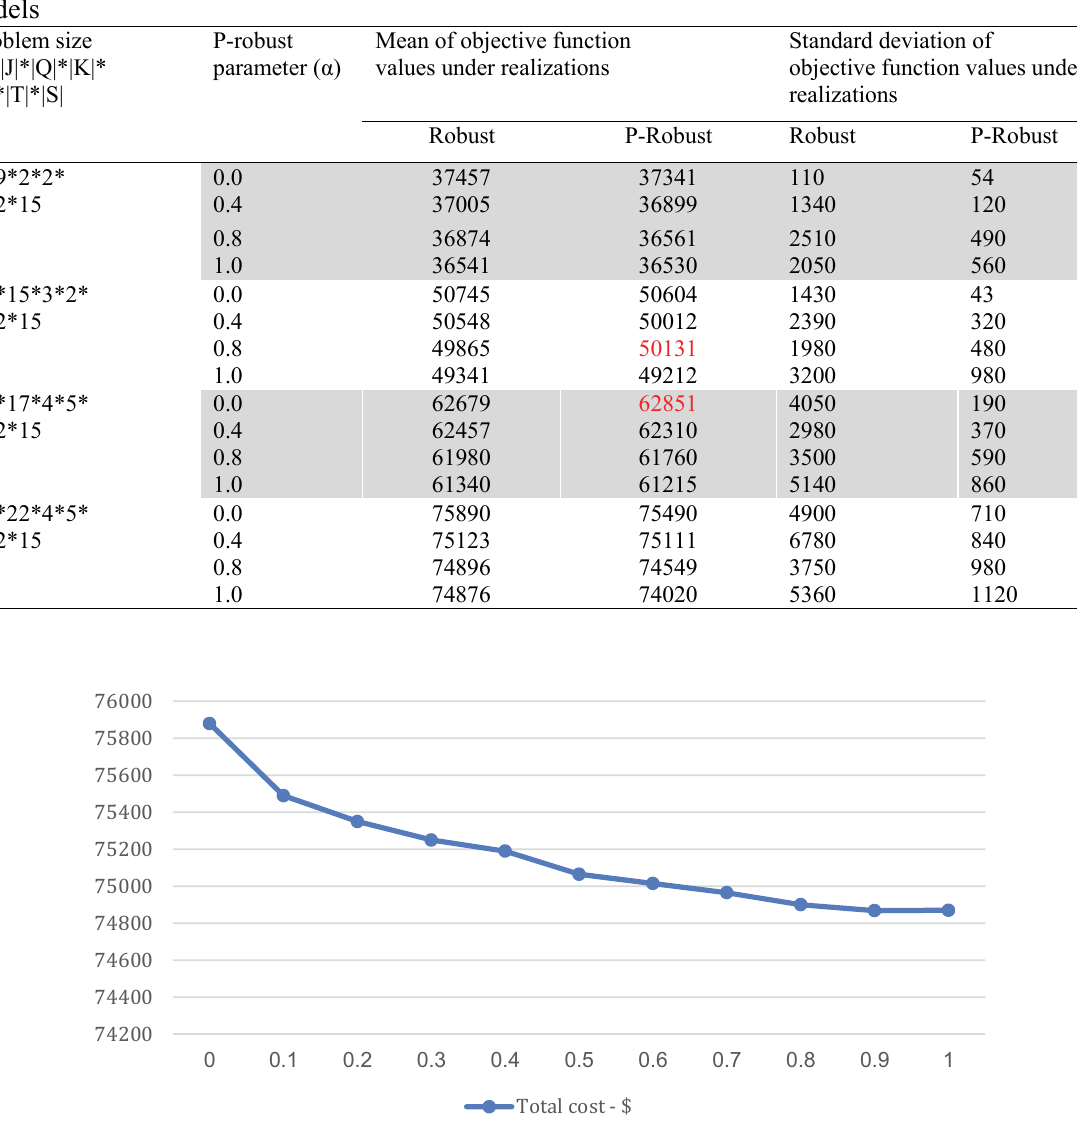
Summary of test results of the second objective function value and the standard deviation of both